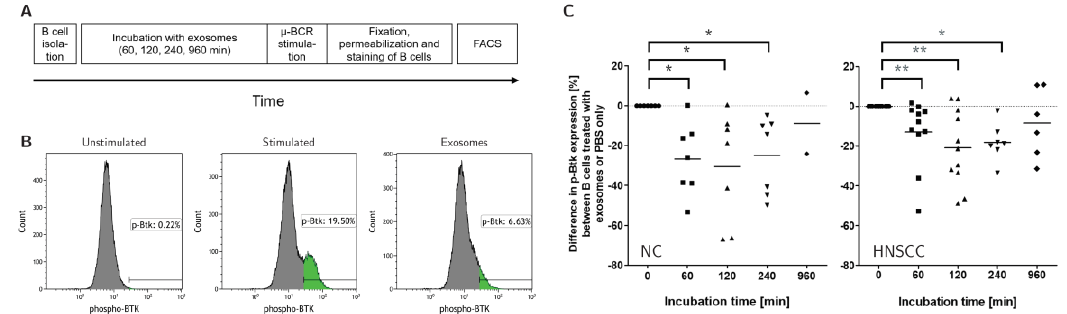
Figure 6. E ff ects of Plasma-derived Exosomes on the activity of the B-cell-receptor pathway. ( A ) B cells isolated from healthy donors were incubated with exosomes for up to 16 h. After stimulation of the B-cell receptor (BCR), fixation and permeabilization, B cells were stained with an antibody against phosphorylated Bruton’s Tyrosine Kinase (p-BTK) to assess the activity of the BCR pathway. ( B ) Exemplary FACS plots of B cells after BCR stimulation and exosome treatment show that BCR stimulation results in enhanced expression of p-BTK, while exosome treatment reduces this effect. ( C ) Treatment with both NC and HNSCC exosomes reduced the expression of p-BTK after BCR stimulation. B cells were incubated with exosomes or PBS as a control for 60 to 960 min. The percent